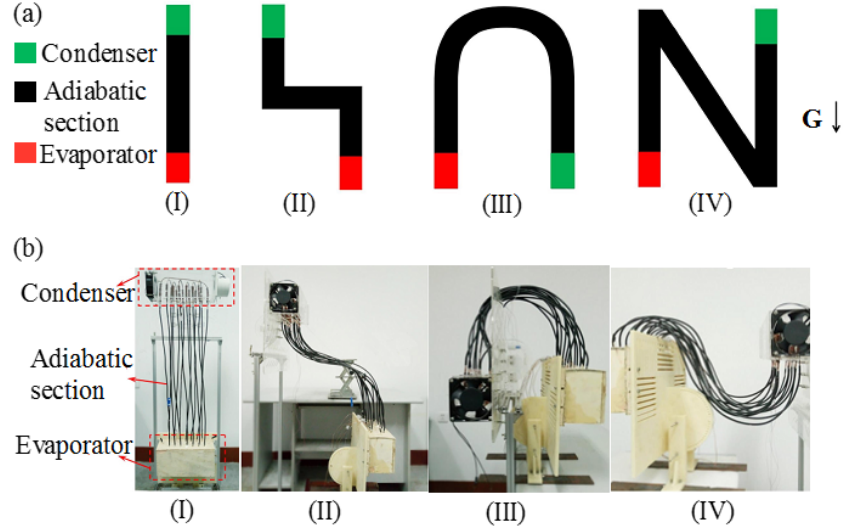
Figure 16. Schematic diagram ( a ) and photo ( b ) of FPHP with different flexible structures: (I) “I” shape, (II) “Ladder” shape, (III) “inverted-U” shape, and (IV) “N” shape [149]. Qu et al. (2017).